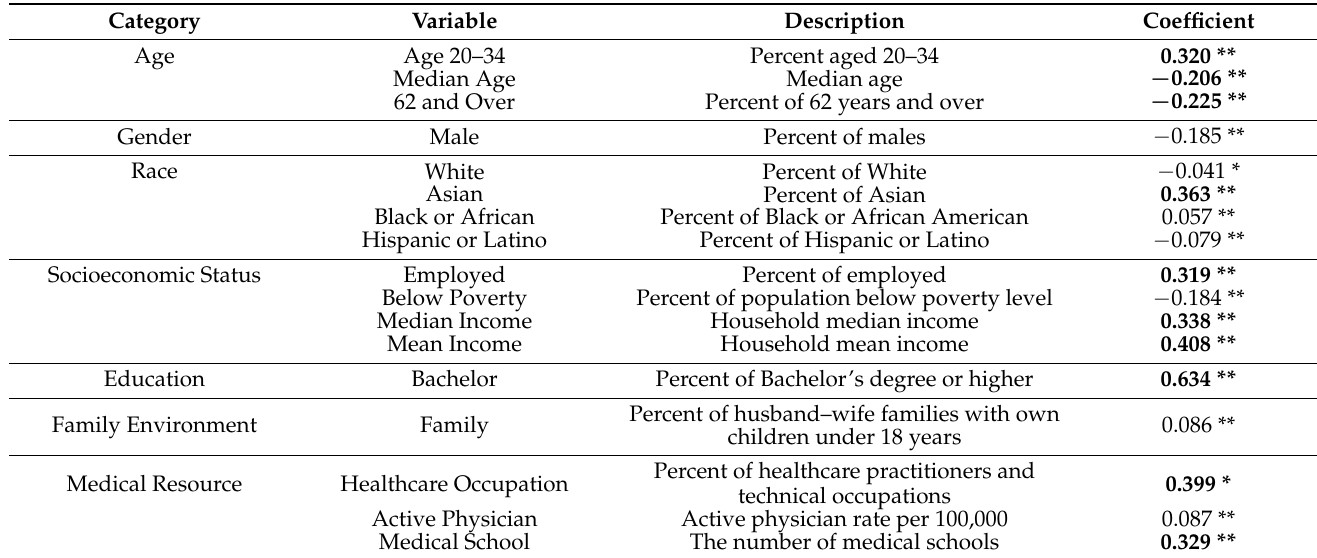
Table 5. Summary statistics of explanatory